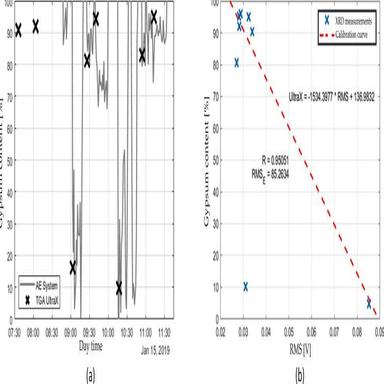
Gypsum content derived from the AE system and the TGA (a) with the calibration curve (b).